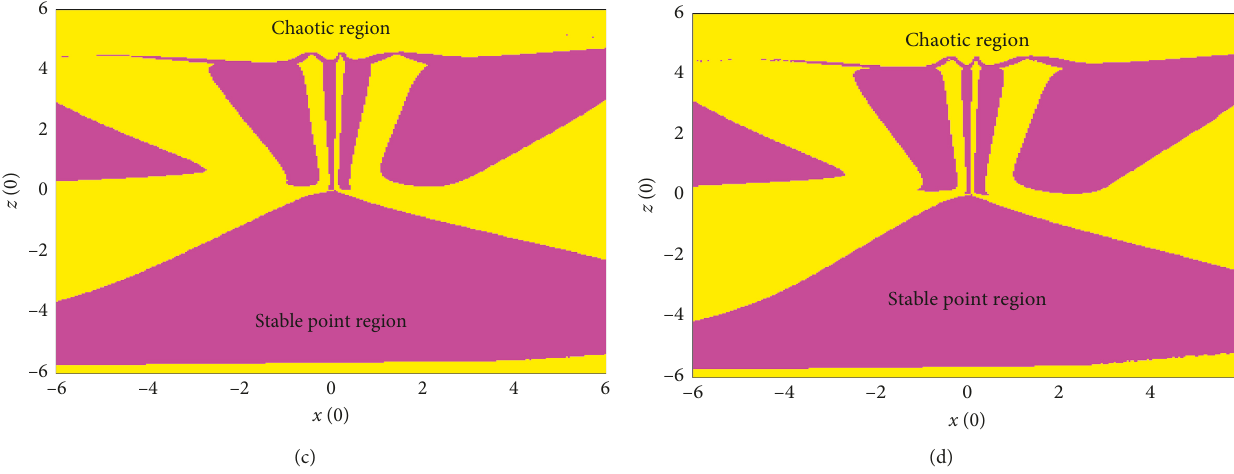
Figure 5: Bistability behaviors demonstrated by the attraction basins in the x ( 0 ) − y ( 0 ) plane for four different fractional orders with y ( 0 ) � 0 . 1. (a) Attraction basin for α � 0.96; (b) attraction basin for α � 0.97; (c) attraction basin for α � 0.98; (d) attraction basin for α � 0.99.